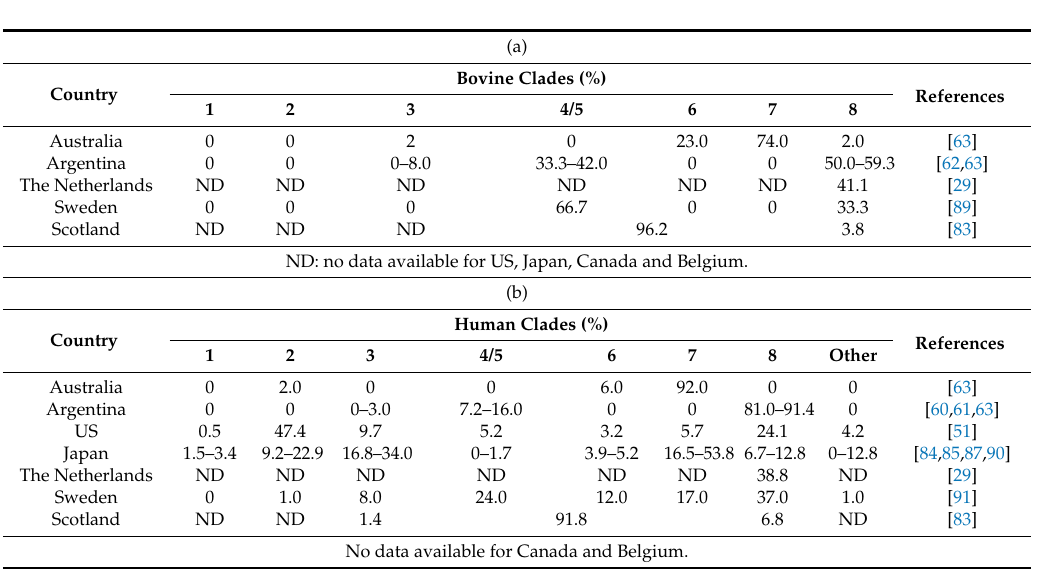
Table 3. Values (or interval of values from different sources) of clade frequency in (a) bovine and (b) human E. coli O157 strains from different countries.